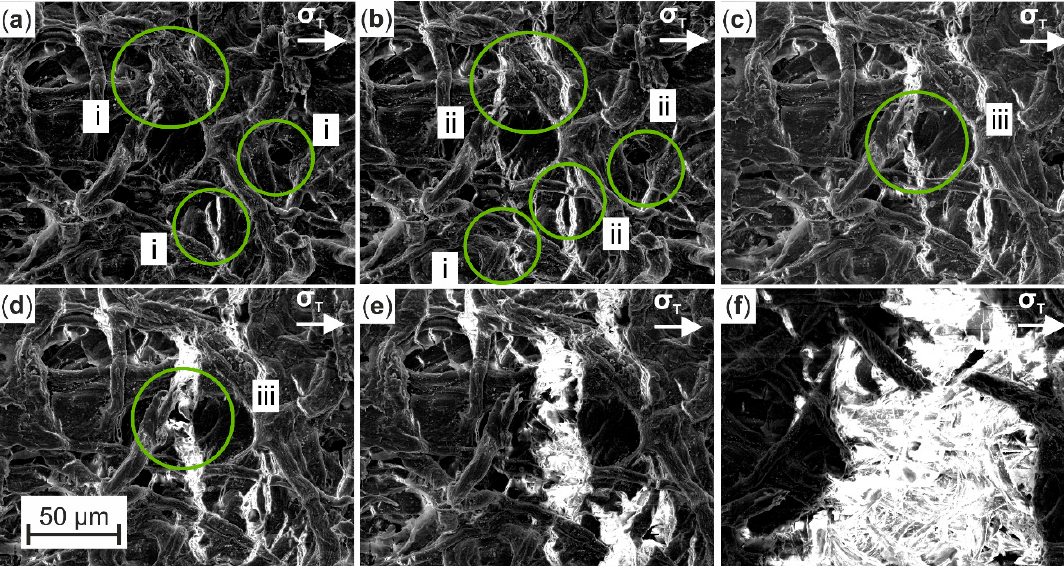
Figure 7. Exemplary in situ SEM monitoring of development of surface defects (i: crack initiation, ii: crack propagation, iii: crack assembly) due to increasing tensile loading of the specimen until final failure: ( a ) crack initiation (i) at critical areas; ( b ) crack propagation (ii) throughout the whole structure; ( c , d ) crack assembly (iii); ( e ) complete loss of structural integrity; ( f ) final failure.